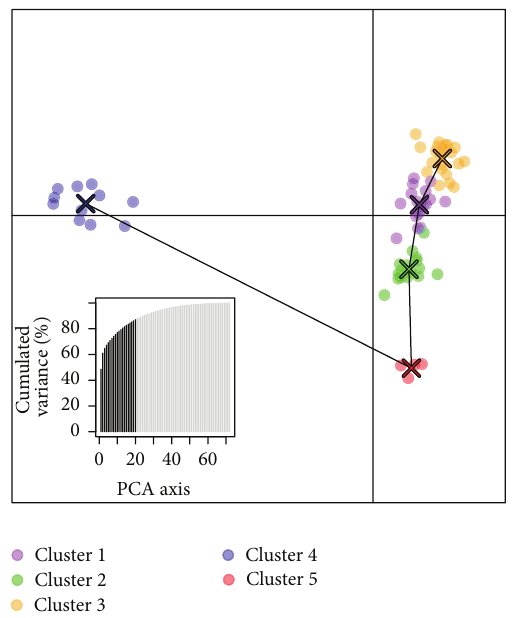
Figure 3: Discriminant Analysis of Principal Components (DAPC) scatterplotdrawnusing124outliersinglenucleotidepolymorphisms (SNP) across 73 Nothofagus dombeyi individuals in the R package adegenet. Dots represent individuals, with colours denoting cluster allocation.PercentagesofcumulatedvarianceexplainedbyPrincipal Component 1 (PC1) to PC20 are shown in the bottom left corner. Minimum spanning tree based on the (squared) distances between clusters within the entire space is shown.